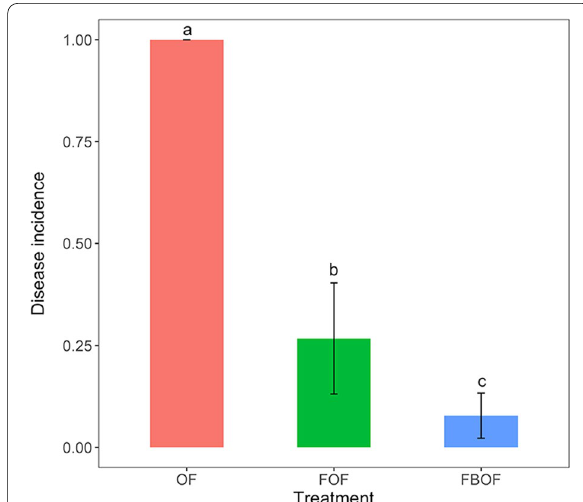
Fig. 1 Disease incidence of watermelon Fusarium wilt in different treatments. OF organic fertilizer, FOF dazomet fumigation followed by organic fertilizer, FBOF dazomet fumigation followed by biological organic fertilizer. Different lowercases indicate a significant difference at the 0.05 probability level according to the Duncan test